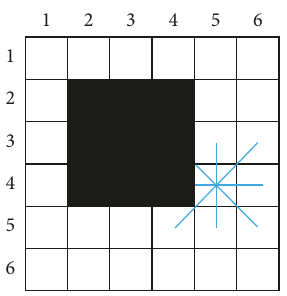
Figure 3: Schematic diagram of the ant colony optimization algorithm search process.